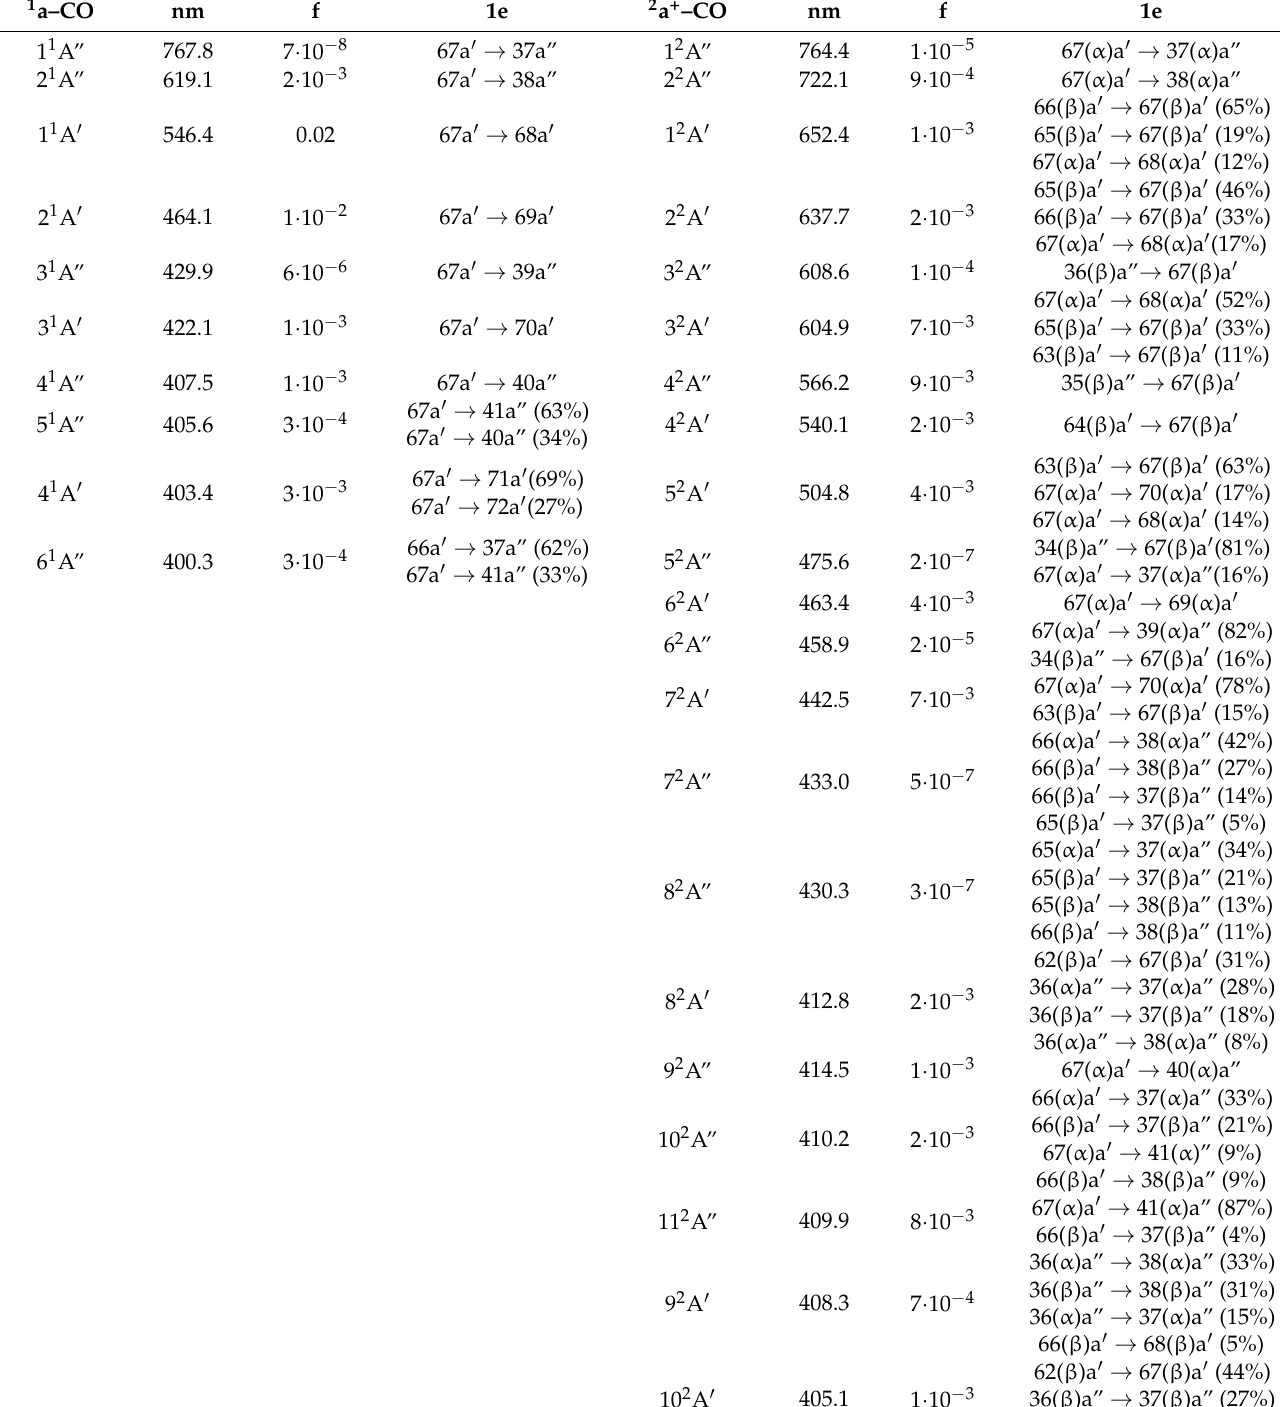
Table 2. Computed excited-state energies, state compositions, and oscillation strengths for a–CO and 2 a + –CO . For each transition is reported the molecular term of the corresponding excited state, the excitation energy (in nm), the oscillation strength (f), and the main mono-electronic excitations with the corresponding percentage MO composition. A representation of all relevant MOs involved in electronic transitions can be found in Figure